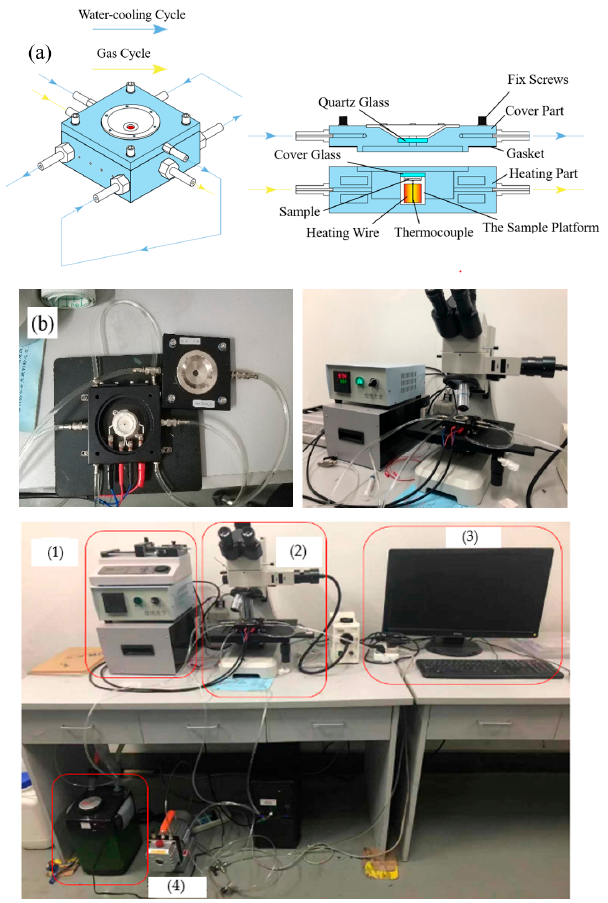
Figure 1. The sinter visualization system: ( a ) hot stage structure and ( b ) photograph of the hot stage. (1) Temperature control device; (2) high-temperature microscope with charge-coupled device (CCD) camera; (3) computer; (4) circulation pump.